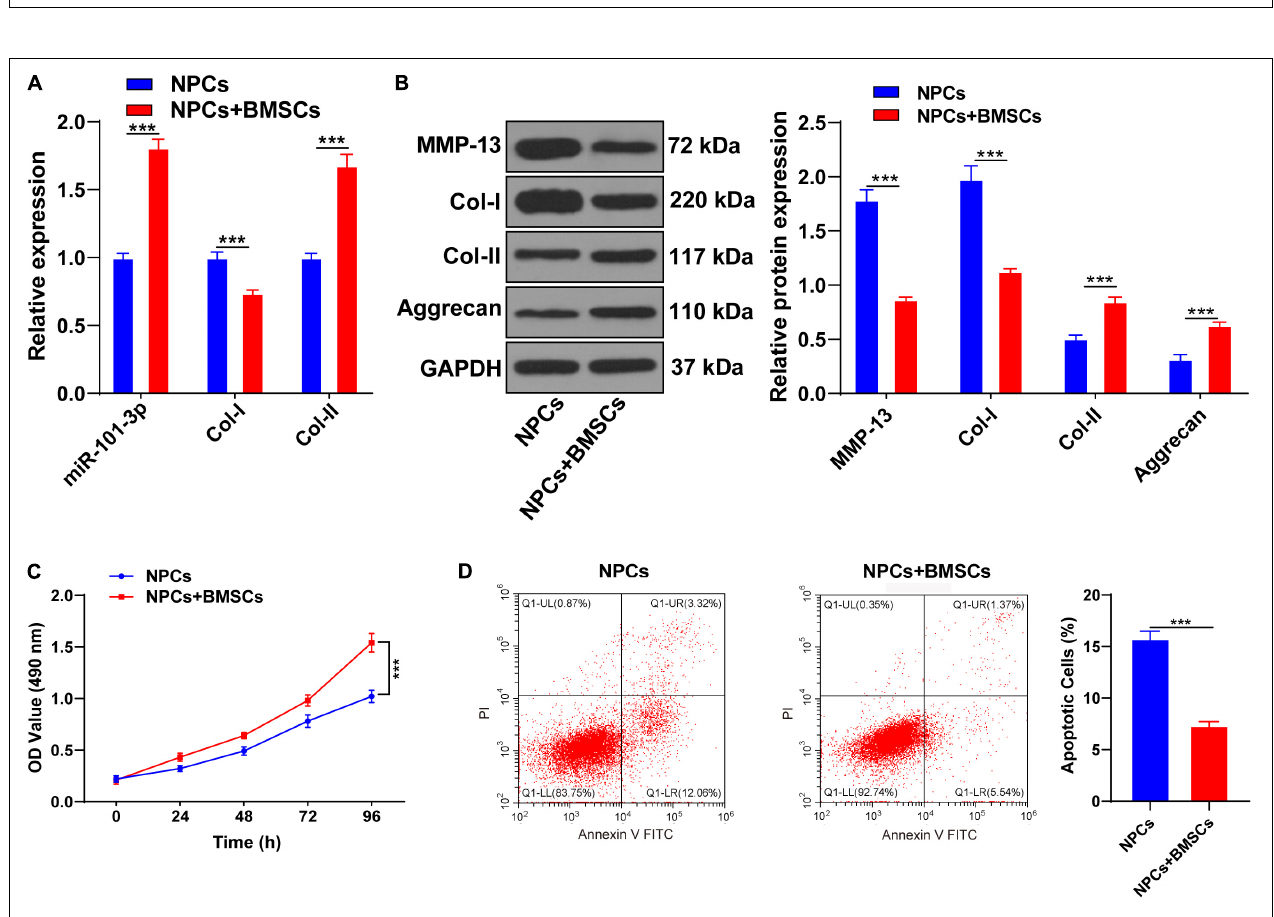
FIGURE 2 | Bone mesenchymal stem cells (BMSCs) promoted ECM remodeling of NPCs. NPCs of patients with IDD were cocultured with BMSCs, with NPCs cultured alone as the control. (A) miR-101-3p, Col-I, and Col-II expressions were detected using the RT-qPCR; (B) MMP-13, Col-I, Col-II, and Aggrecan levels were detected using Western blotting; (C,D) the effects of BMSCs on the viability and apoptosis of NPCs were detected using MTT assay and flow cytometry. The cell experiments were repeated three times independently. Data are presented as mean ± SD. Data in panels (A–C) were analyzed using the independent sample t -test, *** p <